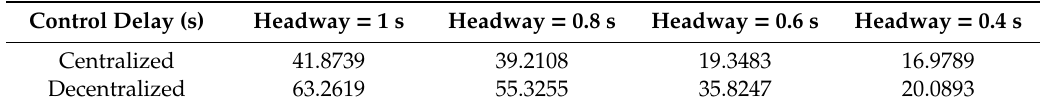
Table 6. Average delay for two control algorithms.